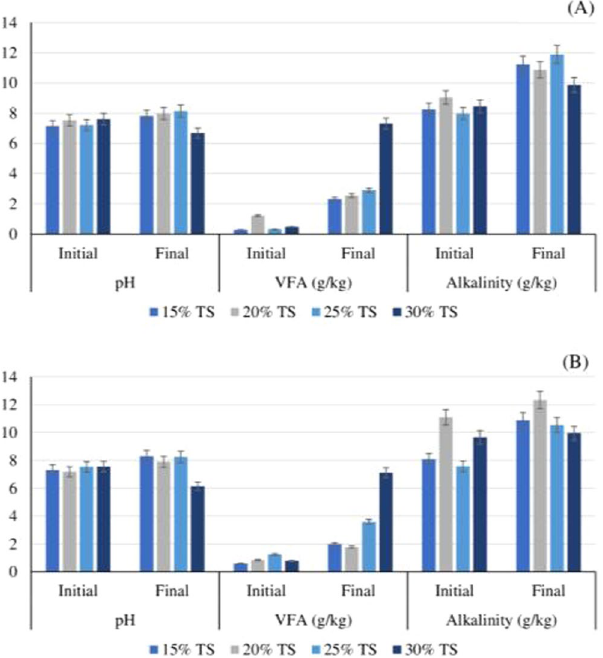
Figure 2. Reactor characteristics (p < 0.05) before and after 60 days of SSAD of PMS. (A – Mesophilic; B – Thermophilic).